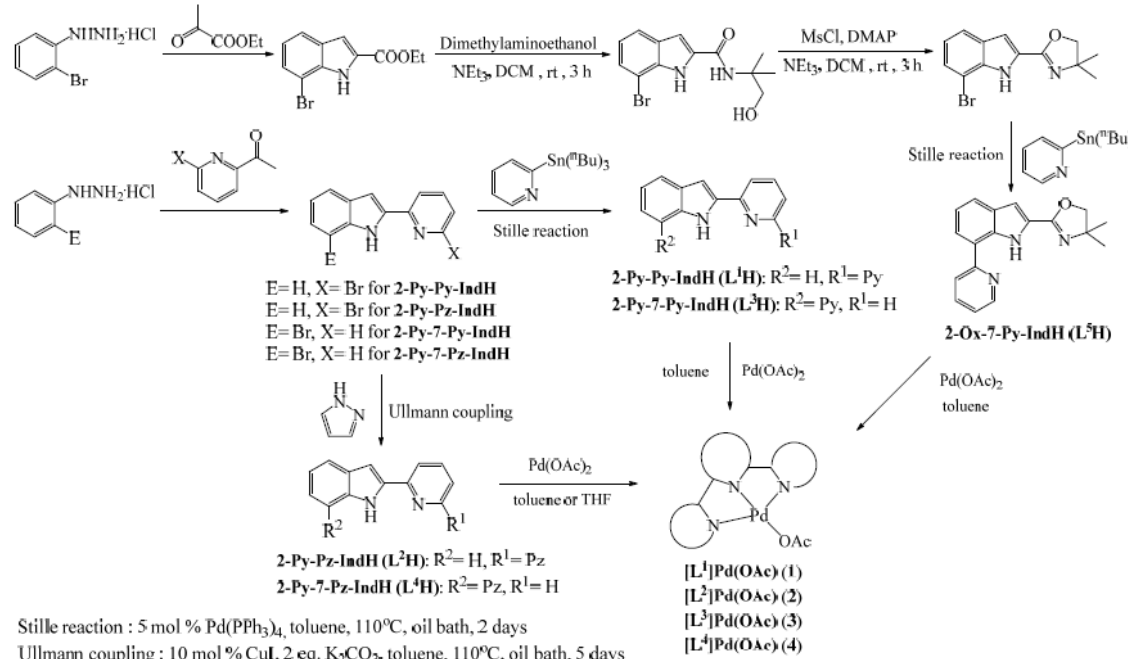
Scheme 1. Preparation of ligand precursors and palladium complexes.